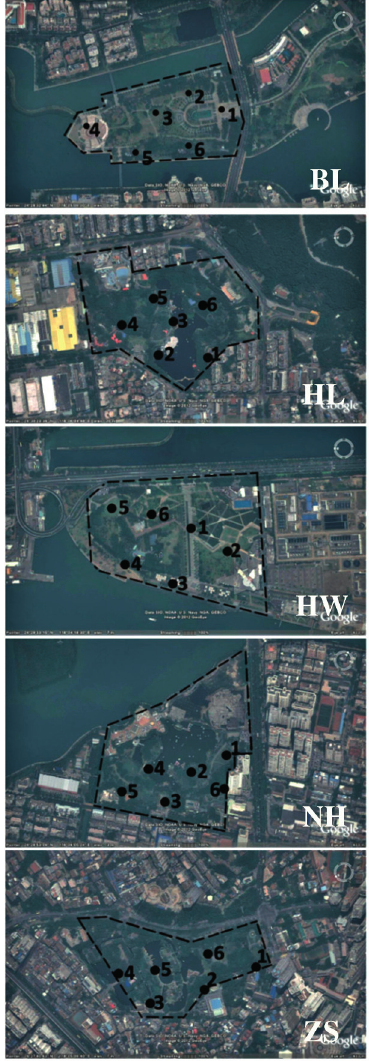
Fig. 1. Images of the five studied city parks from Google Earth, shown with the areas with broken line, BL: Bailuzhou (west), HL: Huli, HW: Haiwan, NH: Nanhu, zS: